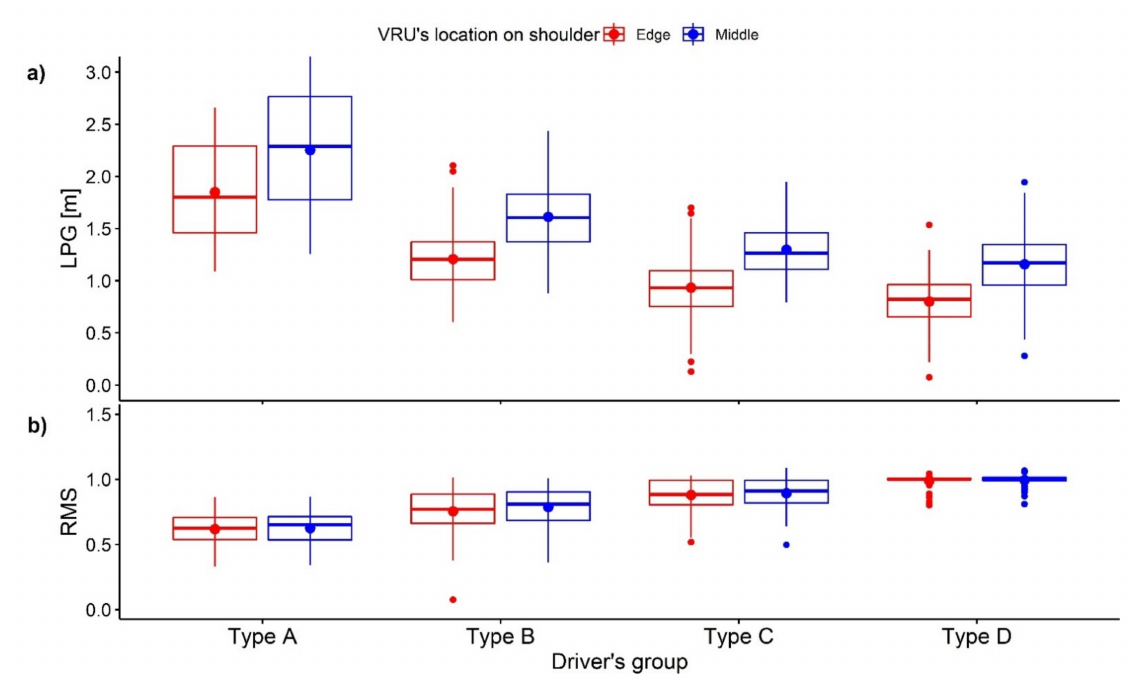
Figure 8. Box plots of the minimum lateral gap while passing VRU ( a ) and the ratio of SV’s minimum velocity to initial speed while approaching VRU ( b ), grouped by VRU’s location between driver’s